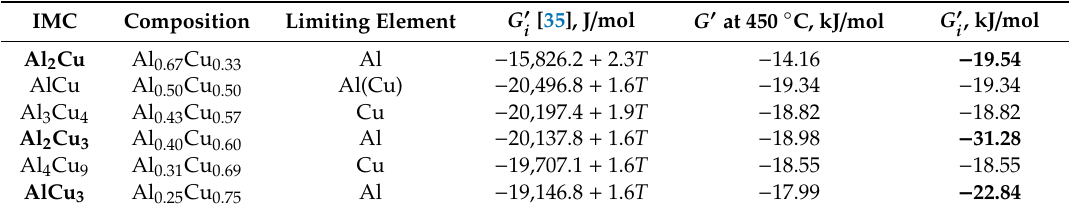
Table 4. E ff ective Gibbs free energy changes at Cu-Al interfaces at 450 ◦